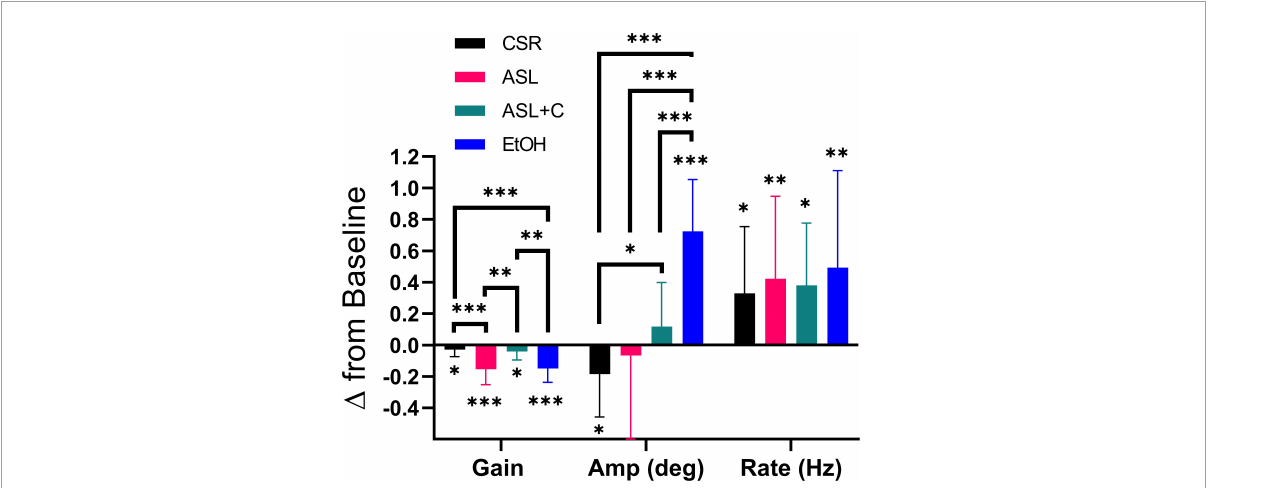
FIGURE5 Differential pursuit and saccade performance with sleep loss and low-dose alcohol. The bar chart depicts the average and standard deviation (SD), with color indicating the experimental condition. Significant deficits in pursuit gain were revealed across all conditions. EtOH largely recouped the loss with an increase in saccade rate and amplitude, whereas ASL showed an increase in saccade rate and a highly variable (insignificant) amplitude change, yielding weaker compensation. CSR showed a smaller pursuit gain deficit, coupled with an unnecessarily large increase in saccade rate that was tempered by a decrease in saccade amplitude. With ASL+C, pursuit gain and saccadic amplitude were similar to baseline, but saccadic rate nonetheless increased unnecessarily. ∗ p < 0.05, ∗∗ p < 0.01, and ∗∗∗ p < 0.001.